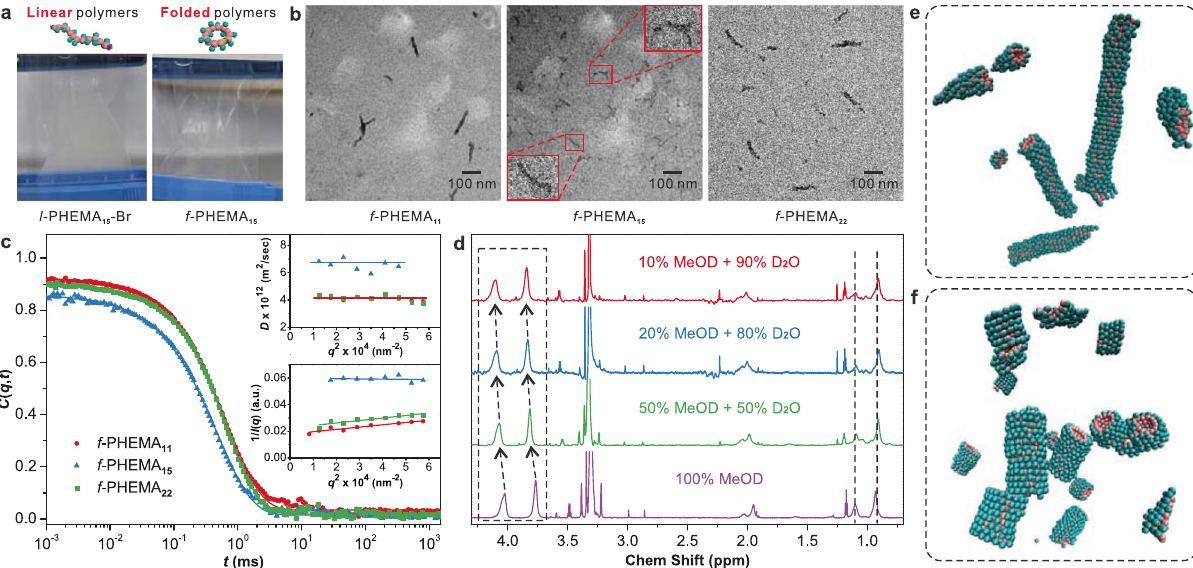
Fig. 2 Self-assembly of linear and folded PHEMA. a Solutions of l -PHEMA 15 - Br and f -PHEMA 15 after dialysis against deionized water for 1 h. b TEM images showing the assemblies of f -PHEMA 11 , f -PHEMA 15 , and f -PHEMA 22 . c Relaxation functions C ( q , t ) for the translation motion of f -PHEMA 11 , f -PHEMA 15 , and f -PHEMA 22 in water at 1 mg mL − 1 and 293 K at a scattering angle of 90° corresponding to scattering wave vector q = 0.0187nm − 1 . Upper inset: The translation diffusion coef fi cient, D as a function of q 2 with the solid line indicating a virtually q -independent D . Lower inset: 1/ I ( q ) as a function of q 2 . d 1 H NMR spectra (850 MHz, 298.3 K) of f -PHEMA 15 in mixtures of MeOD and D 2 O with gradually tuned volume ratios. The chemical shifts were calibrated using tetramethylsilane as an internal standard. e , f Molecular dynamic simulation snapshots showing the self-assembly of a model simulation replica of f -PHEMA n with two different ring sizes, i.e., n = 9 ( e ) and n = 15 ( f